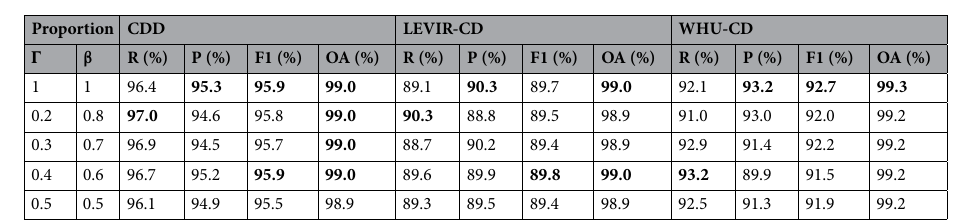
Table 6. Different proportion results of loss function (the best performance is emphasized in bold).